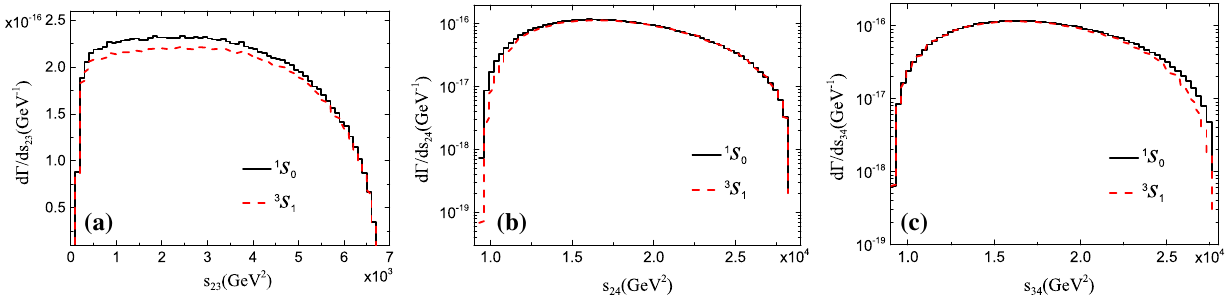
Fig. 7 The differential decay width not via FCNC d (cid:2)/ ds 23 ( a ), d (cid:2)/ ds 24 ( b ) and d (cid:2)/ ds 34 ( c ) for t → | ( c ¯ b ) [ n ](cid:5) + b + Z 0